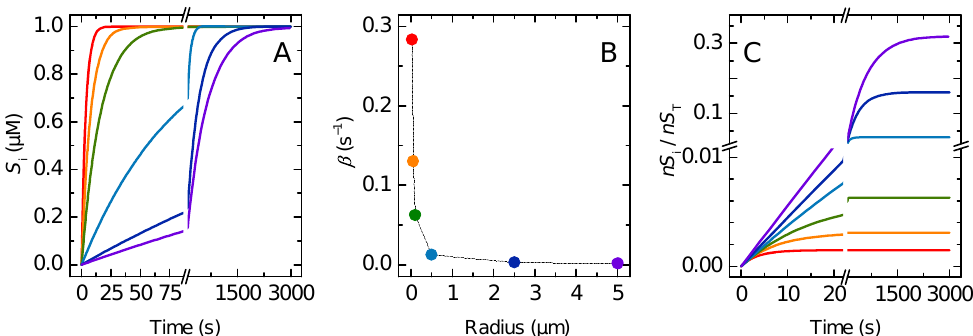
Figure 2. Effect of the vesicle size: ( A ) Dynamics of the total solute concentration in the inner compartments ( S ), ( B ) Characteristic constant of solute accumulation inside the vesicles, and ( C ) i Evolution of the fraction of solute in the inner compartments, for vesicles with a radius of 25 nm ( – ), 50 nm ( – ), 0.1 µ m ( – ), 0.5 µ m ( – ), 2.5 µ m ( – ) and 5 µ m ( –